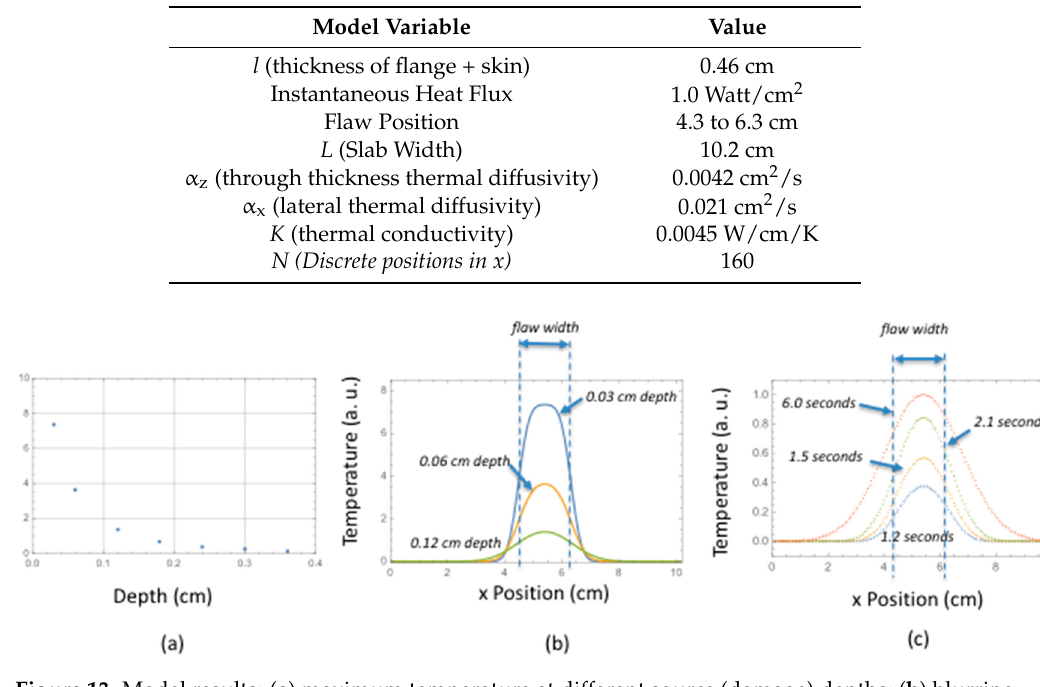
Figure 13. Model results: ( a ) maximum temperature at different source (damage) depths; ( b ) blurring of source edge for different depths; ( c ) blurring of source edge for different times.